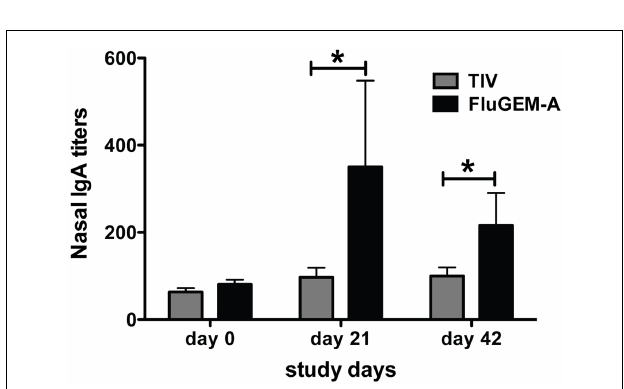
FIGURE 7 | Change in HI titers against (A) influenza B, (B) influenza H1N1 (C) and influenza H3N2 upon vaccination. HI titers in sera of study subjects were measured on study days 0 (baseline titers), 21, and 42. Only titers measured in subjects with baseline < 40 are depicted. For